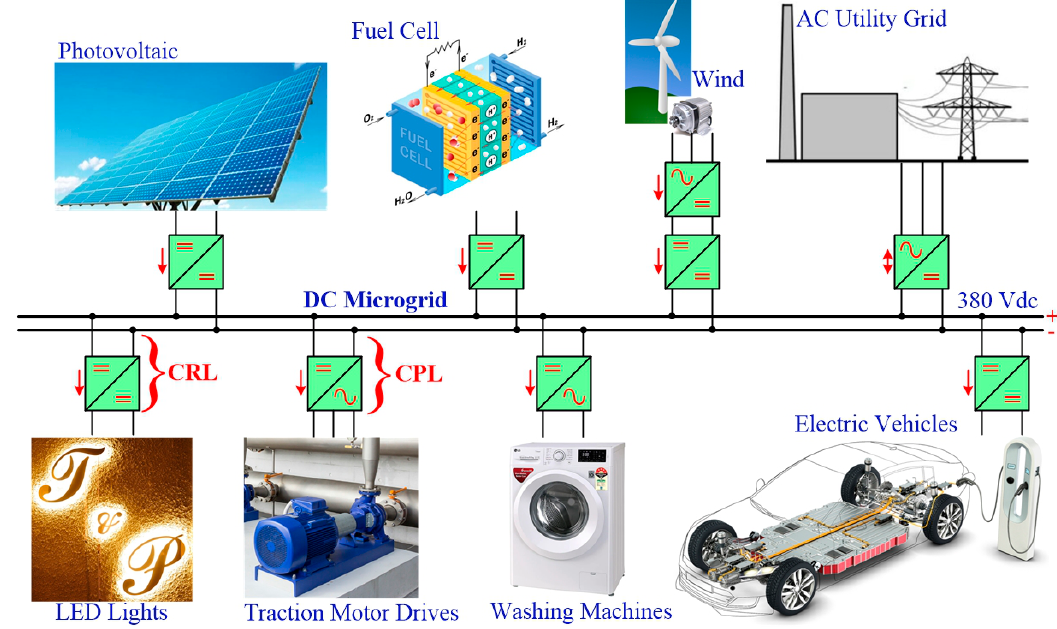
Figure 1. Future direct current (DC) microgrids.